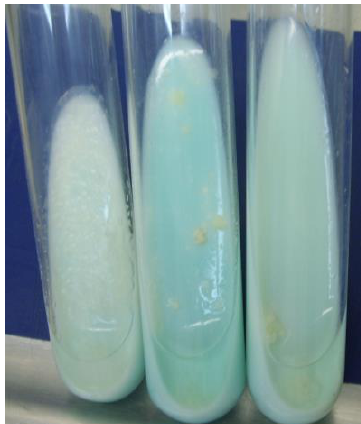
Figure 1. Colony formation of extensively drug resistant tuberculosis (XDR-TB) cells grown on medium with 32 mg/L ofloxacin.